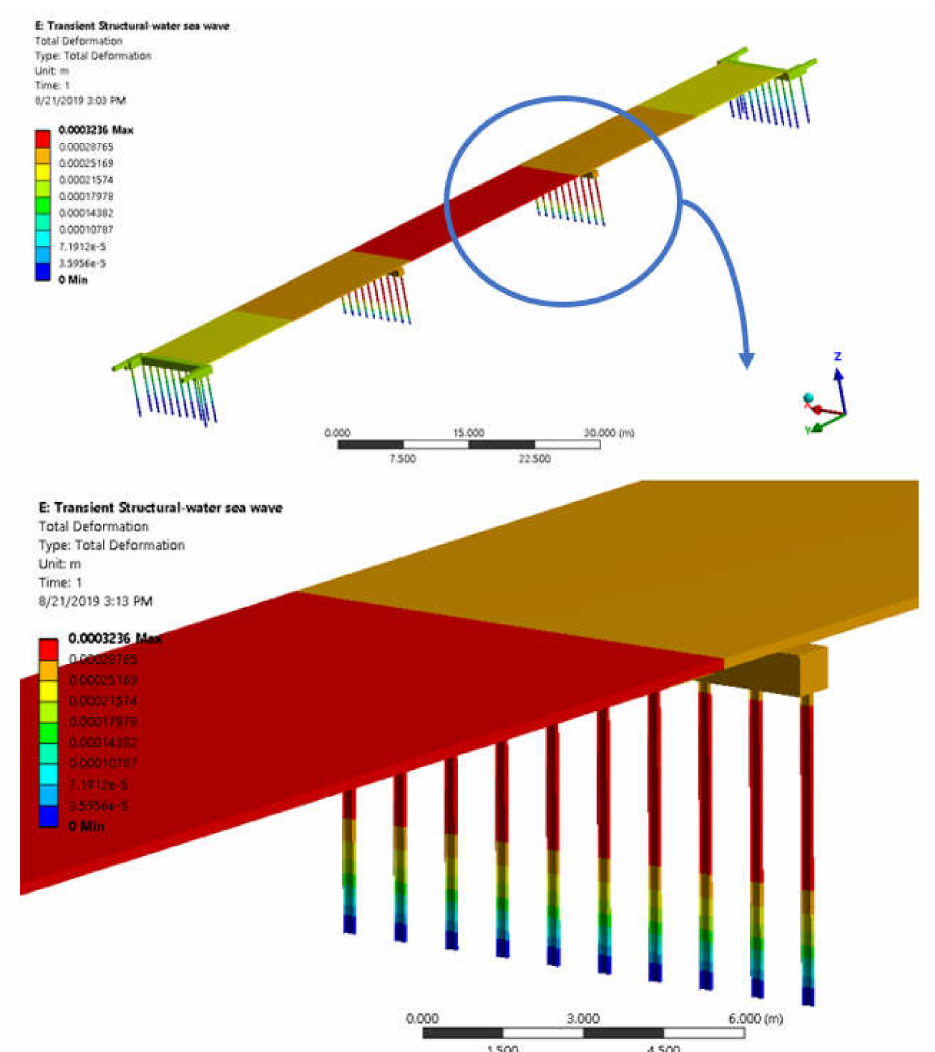
Figure 8. The total deformation of the integral concrete bridge with steel piles due to water waves clash [27].